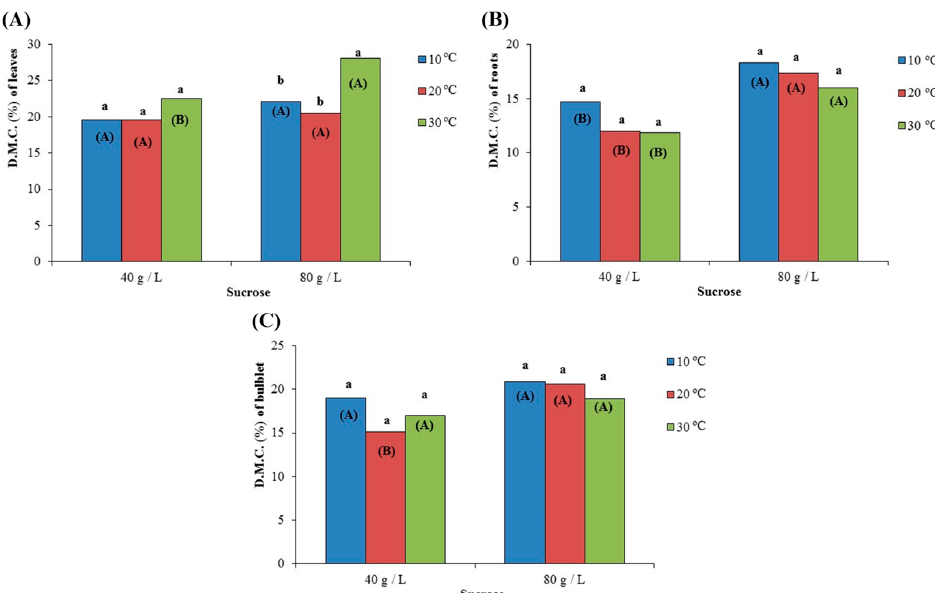
Figure 7. Effect of two different concentrations of sucrose (40 g/L and 80 g/L) at three different temperatures (10 ◦ C, 20 ◦ C, and 30 ◦ C) on the dry matter content (D.M.C. expressed as %) of ( A ) leaves, ( B ) roots and ( C ) bulblet, after growing for 72 days in culture media. In each sucrose concentration, the same lowercase letters indicate non-statistically significant differences among the temperature treatments, according to the LSD test ( p ≤ 0.05). In each temperature, the same uppercase letters in parenthesis indicate no statistically significant differences between sucrose concentrations, according to Student’s t -test ( p ≤ 0.05).